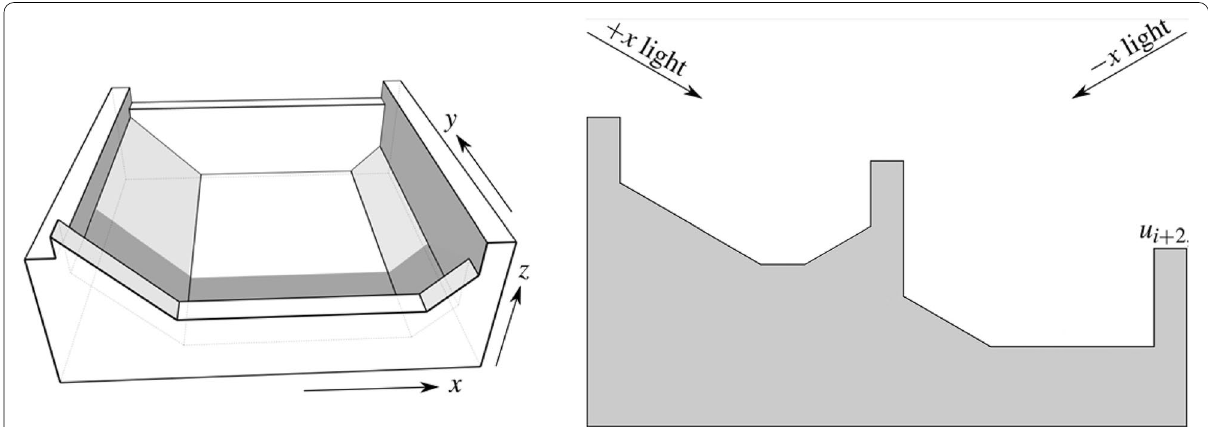
Fig. 7 The local method [15] uses walls and chamfers to create shadows. Each grid corresponds to one pixel in input images. The light source direction, when projected on a xy plane, is parallel to the